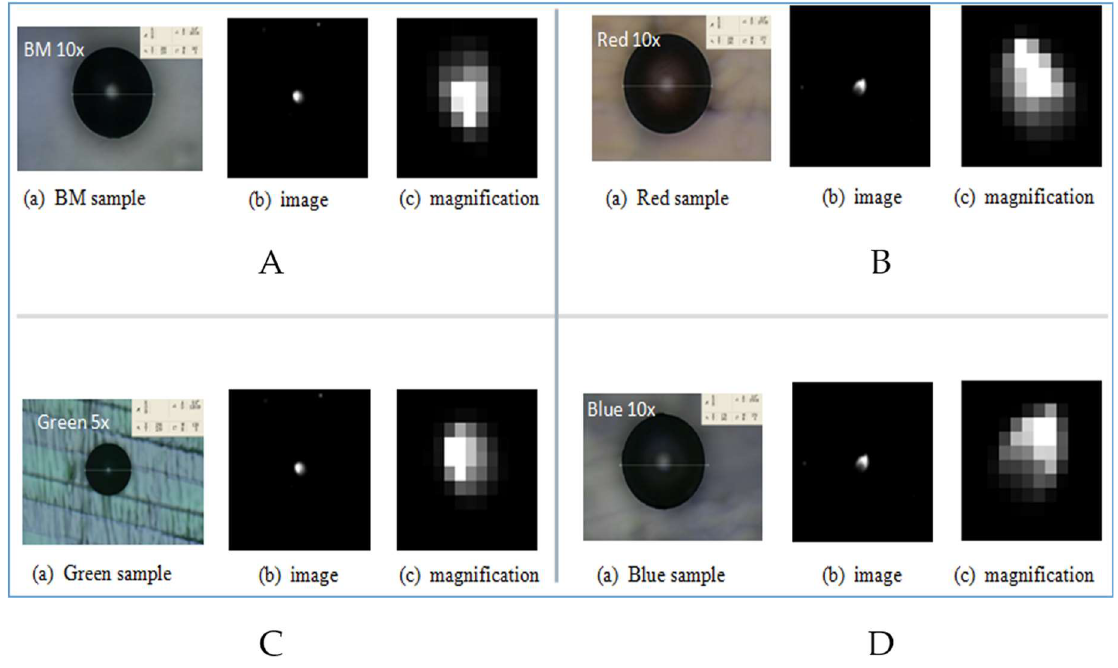
Figure 4. Images and magnifications of various samples. (A): BM sample; (B) Red sample; (C): Green Sample; (D): Blue sample.